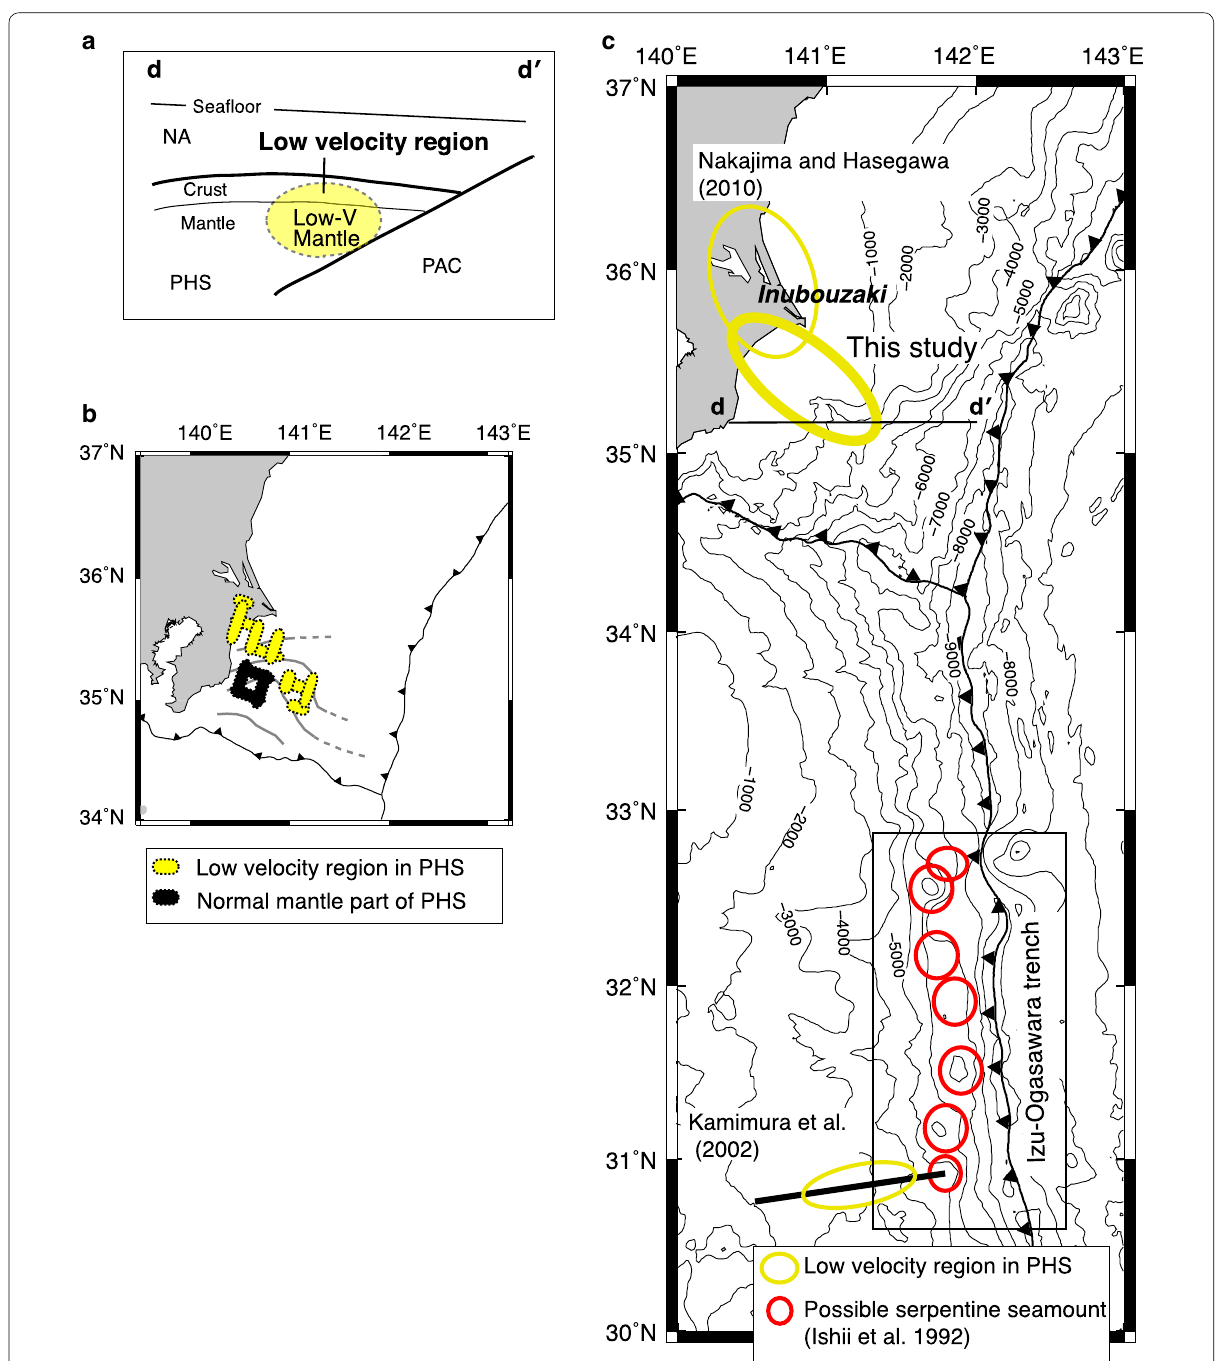
Fig. 14 Low-velocity region in the PHS. a Schematic view for the interpretation of the low-velocity region along line d–d ′ in c . b Distribution of the low-velocity region in this study. Areas shaded yellow and black show the locations of the low-velocity region in the PHS and the normal mantle of the PHS, respectively. c Distribution of the low-velocity region and serpentine seamounts. Yellow and red circles indicate the locations of the low-velocity anomaly according to this and previous studies (Kamimura et al. 2002; Nakajima and Hasegawa 2010) and possible serpentine seamounts (Ishii et al. 1992), respectively. The square shows the study area of Ishii et al.